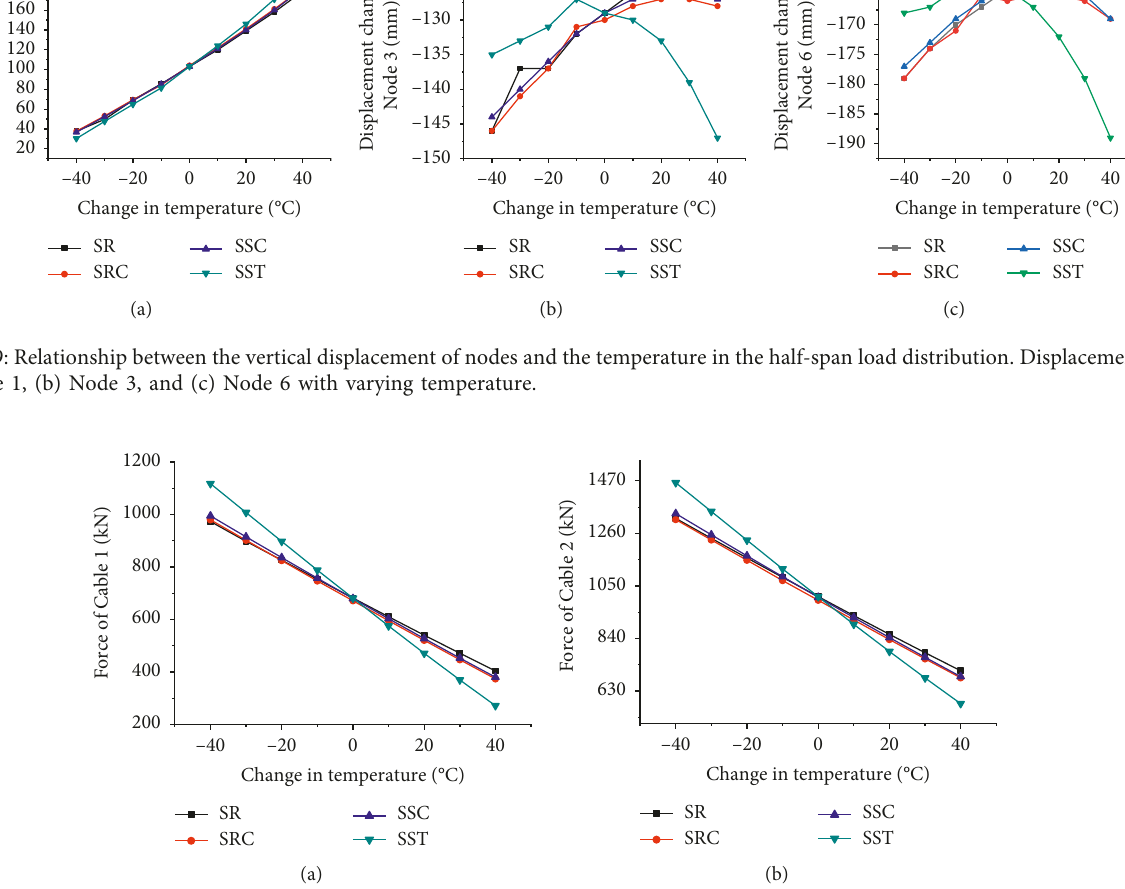
Figure 10: Relationship between the cable force at the end-frame and the temperature in the half-span load distribution. Change in the force of (a) Cable 1 and (b) Cable 2 with varying temperature.